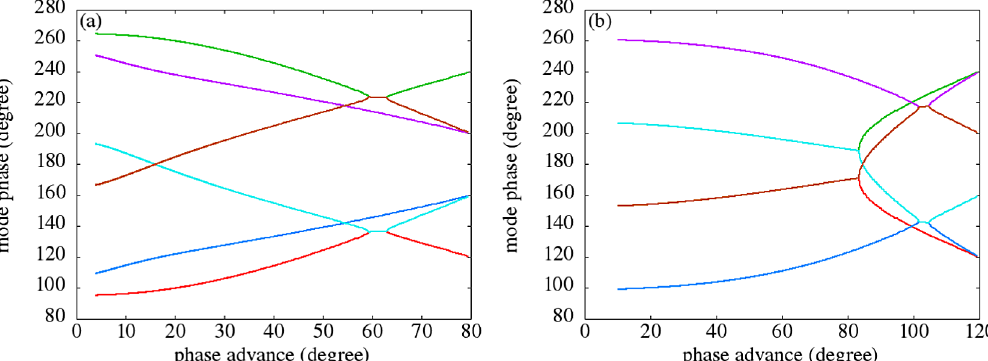
FIG. 12. The 3D envelope mode phases as a function of depressed transverse phase advance for zero current (a) transverse 80 ° and longitudinal 120 °, (b) transverse 120 ° and longitudinal 80 ° phase advance in a periodic quadrupole channel. The six colors are the phases of the six